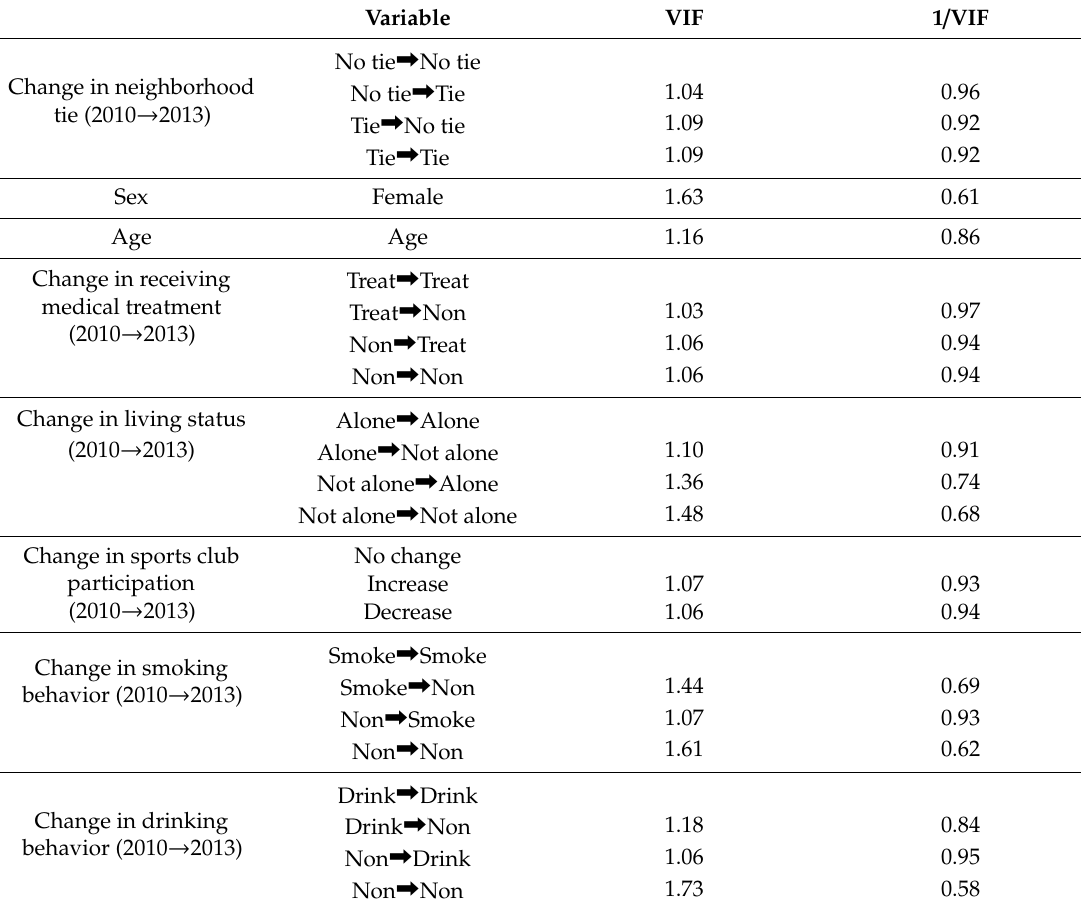
Table A1. Measurement of Variance Inflation Factor